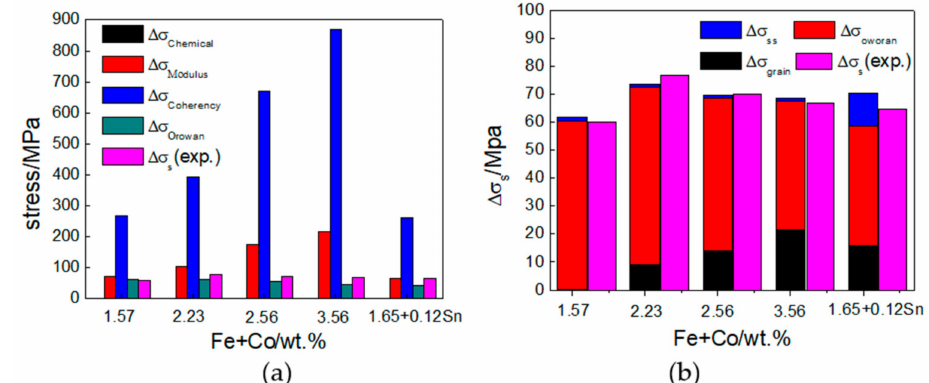
Figure 13. ( a ) Experimental values of overall yield strength increment ∆ σ s (exp.) (purple bar) and predicted precipitation strengthening ∆ σ nanoparticle arising from spherical and petal-like nanoparticles as a function of ∆ σ Chemical (black bar), ∆ σ Modulus (red bar), ∆ σ Coherency (blue bar), and ∆ σ Orowan (green bar); ( b ) Predicted values of overall yield strength increment ∆ σ s containing grain-refined strengthening ∆ σ grain (black bar), solid-solution strengthening ∆ σ ss (blue bar), and precipitation strengthening ∆ σ Orowan (red bar), compared with experimental values of overall yield strength incre- ment ∆ σ s (exp.) (purple bar). The modeling predictions agree with the measured behaviors although it is shown that some refinements to the description of strengthening models are required